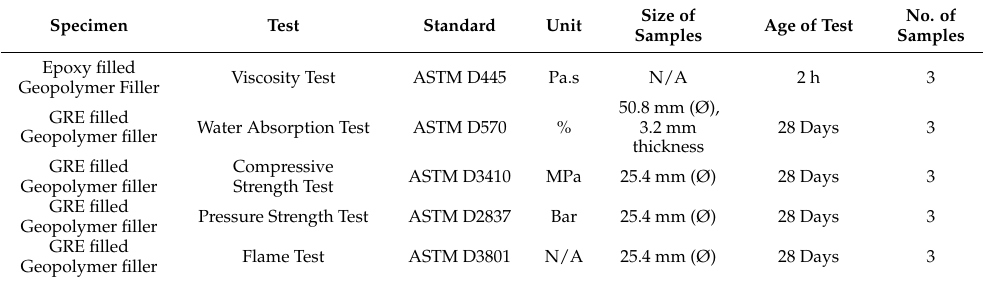
Table 2. Experiment